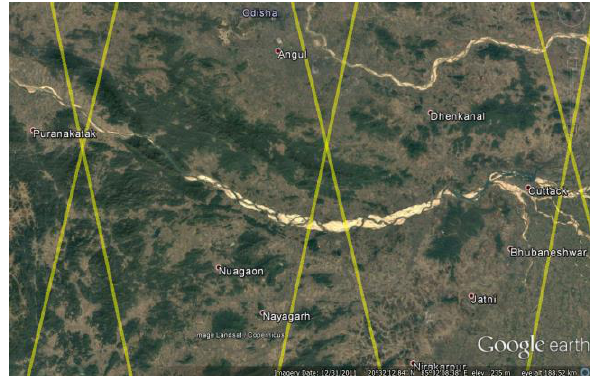
Figure 1. Mahanadi River with Saral-altika tracks